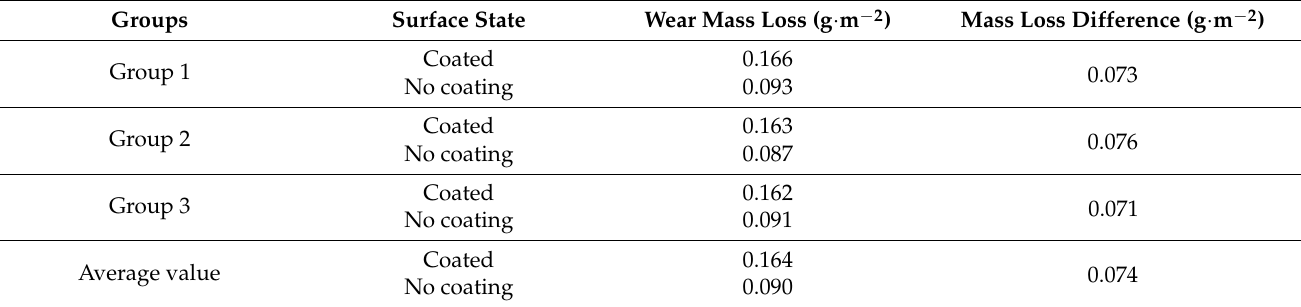
Table 11. Quality loss comparison of wet wheel wear specimens.